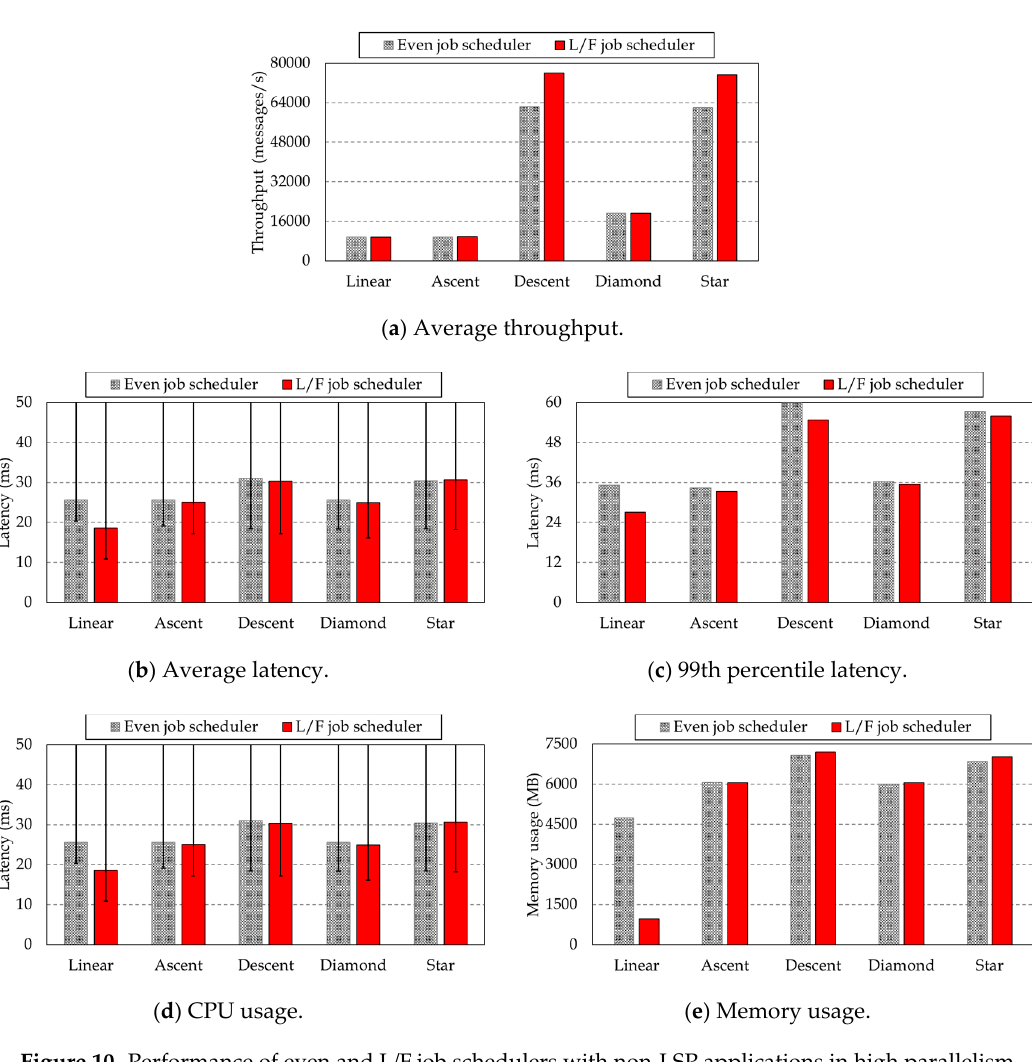
Figure 10. Performance of even and L/F job schedulers with non-LSP applications in high parallelism.